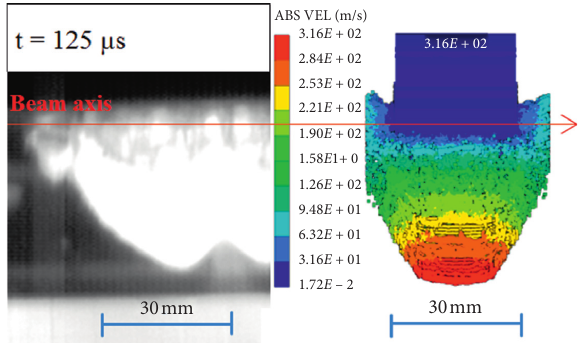
Figure 27: Temperature on the Inermet ® 180 target 25 µ s after the high-energy impact. The ongoing material flow towards the surrounding is clearly visible, and the target deformations are in true scale.